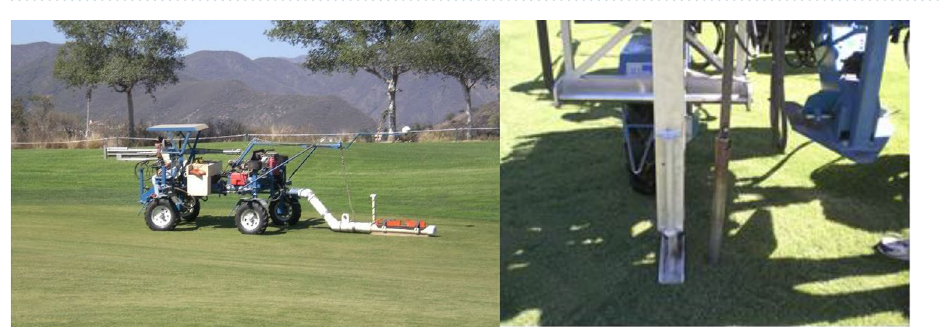
Figure 3. ( a ) EM 38 remote sensing field vehicle with EM38 unit positioned for EC measurements at the site. ( b ) Close up of soil coring instrument mounted to field